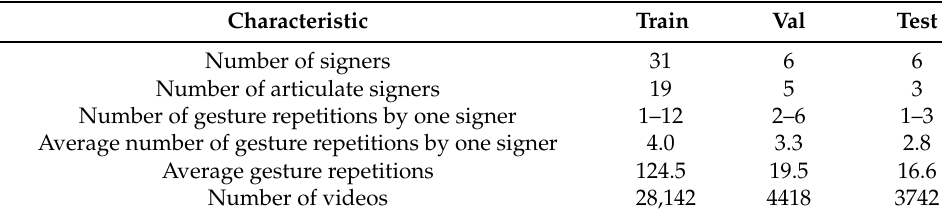
Table 2. AUTSL dataset characteristics.